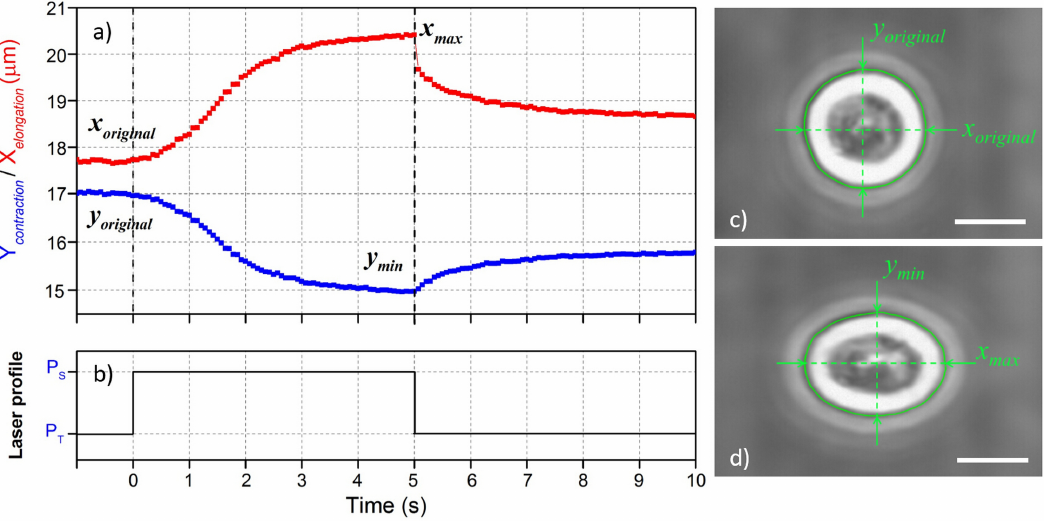
Figure 11. Single cell optical stretching. ( a ) Cell dimension variation during optical stretching together with the laser power profile ( b ): P T is trapping laser power of 25 mW per side and P S is stretching power of 1.5 W per side. X -axis is along the laser beam and Y -axis along the cell flowing direction; ( c , d ) show the phase contrast microscope images of the same cell trapped and stretched respectively. Green contours are cell borders identified by the recognition algorithm. Scale bars in both ( b , c ) are 10 µm. The cell sample is human breast cancer cell